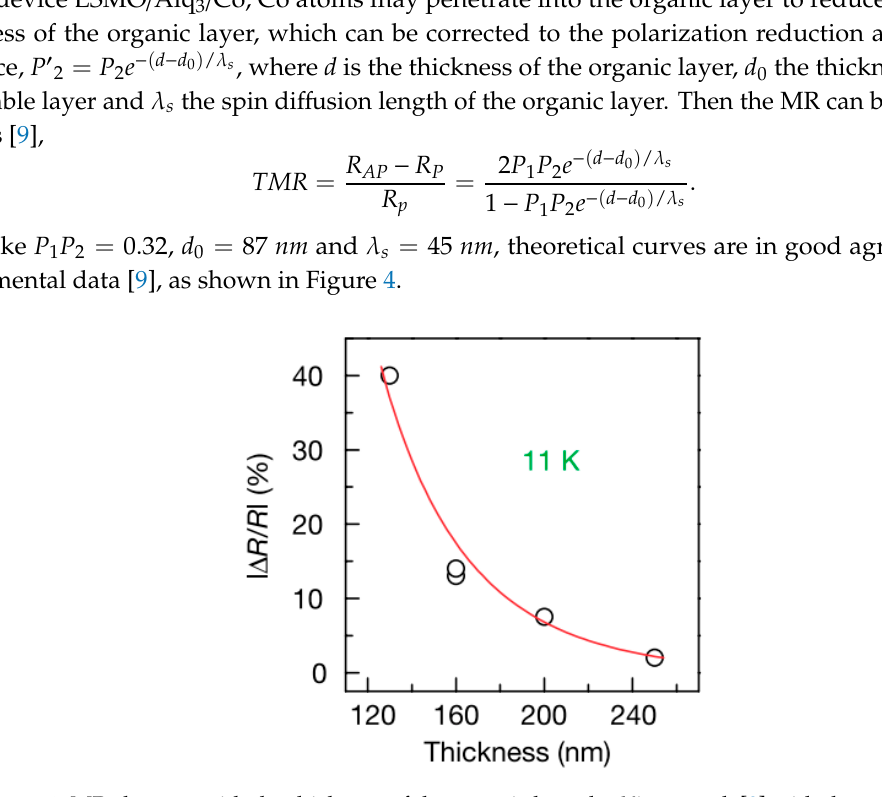
Figure 4. MR changes with the thickness of the organic layer by Xiong et al. [9] with the permission of Nature.